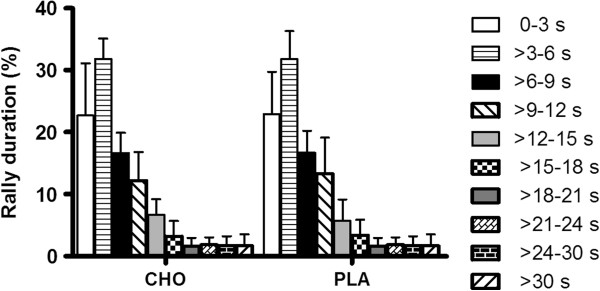
Distribution of rallies duration (%; mean±SD) during PLA and CHO conditions.